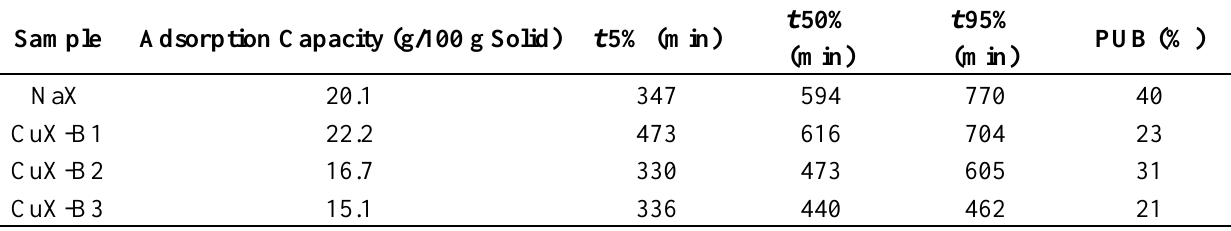
Table 4. Adsorption parameters of the NaX and copper-exchanged